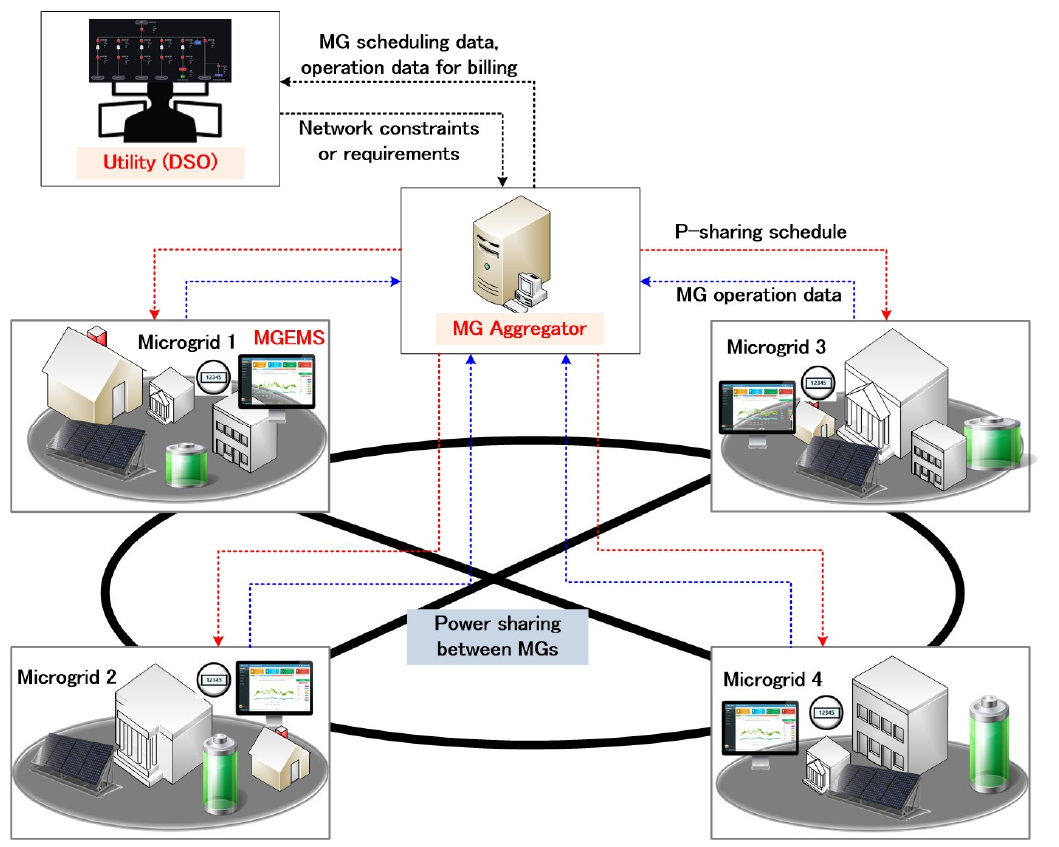
Figure 1. Schematic of the proposed hierarchical energy management system.